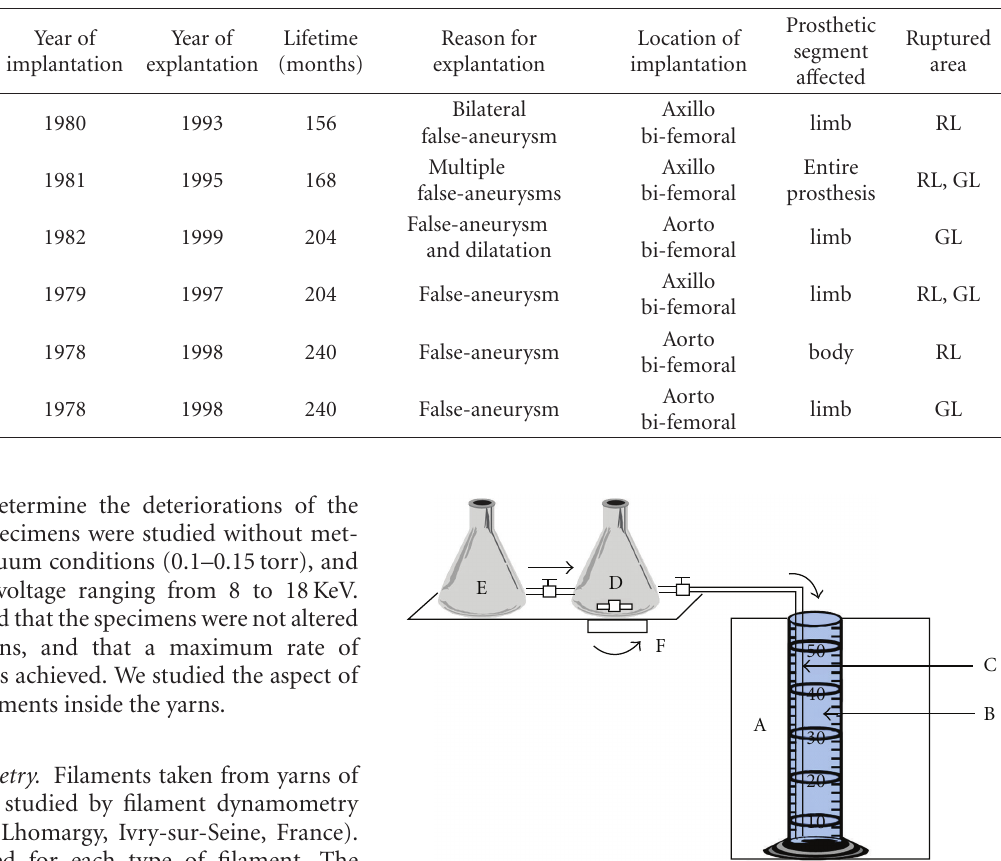
Table 1: Main characteristics of the explanted grafts. Reference number is the reference number given in the first clinical description of the series. (MDV: Microvel Double Velour; CDV: Cooley Double Velour; RL: remeshing line; GL: guide line).